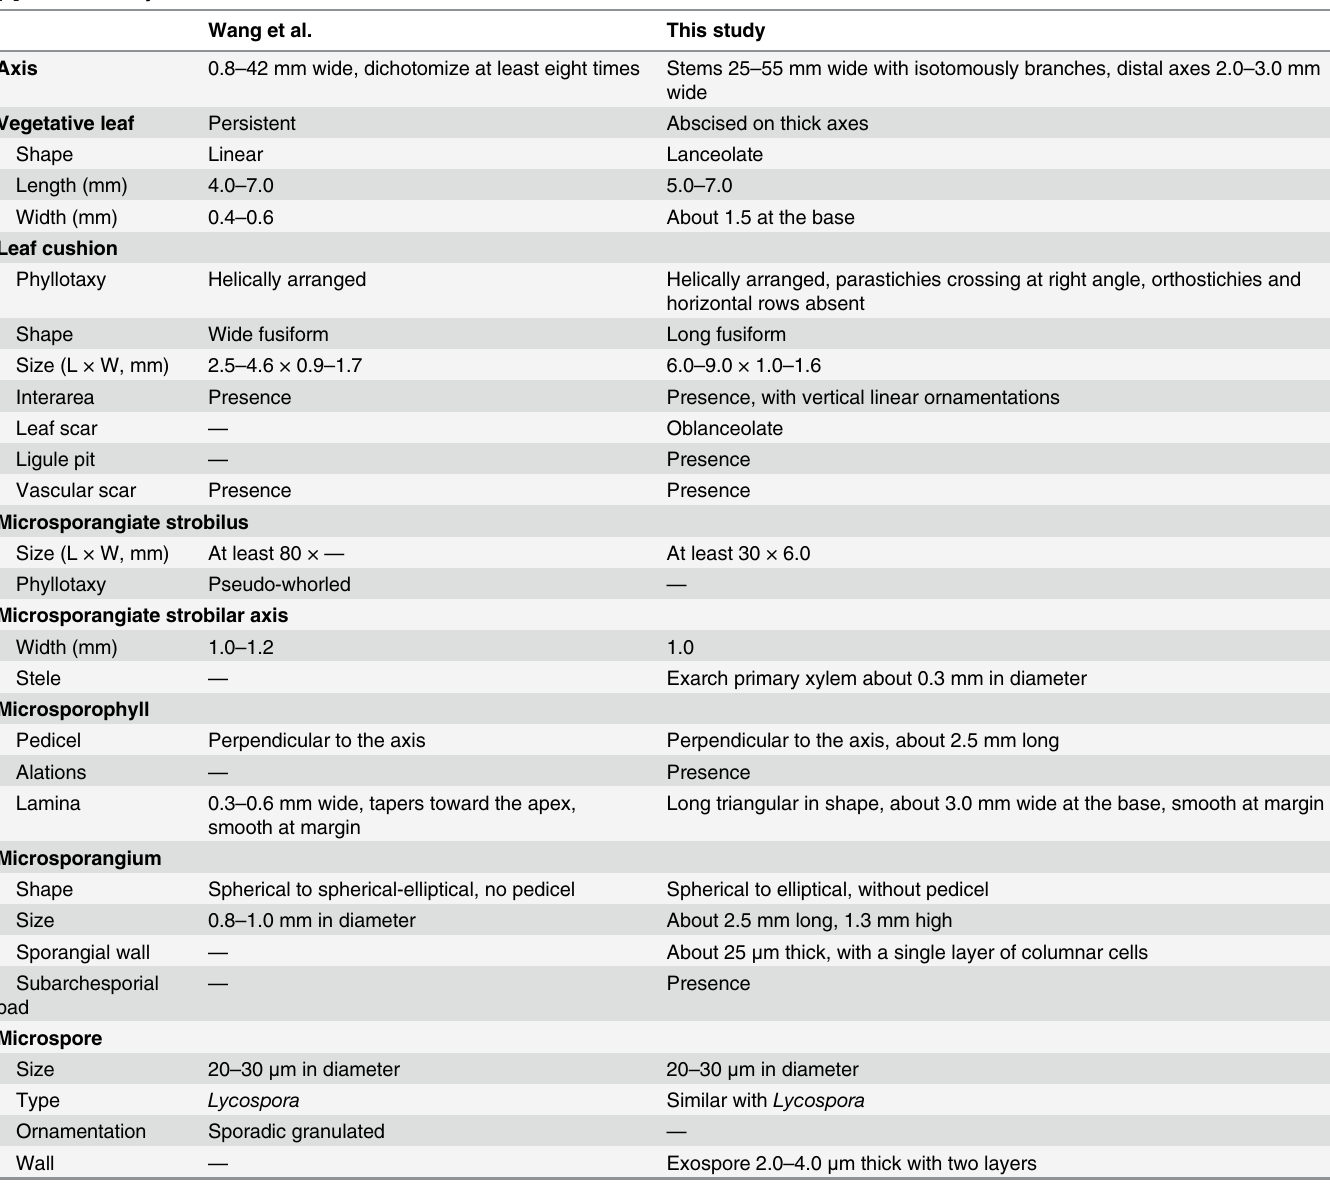
Table 1. Comparisons of main characters of Minostrobus chaohuensis (vegetative axis and microsporangiate strobilus) described by Wang et al. [8] and this study. Wang et